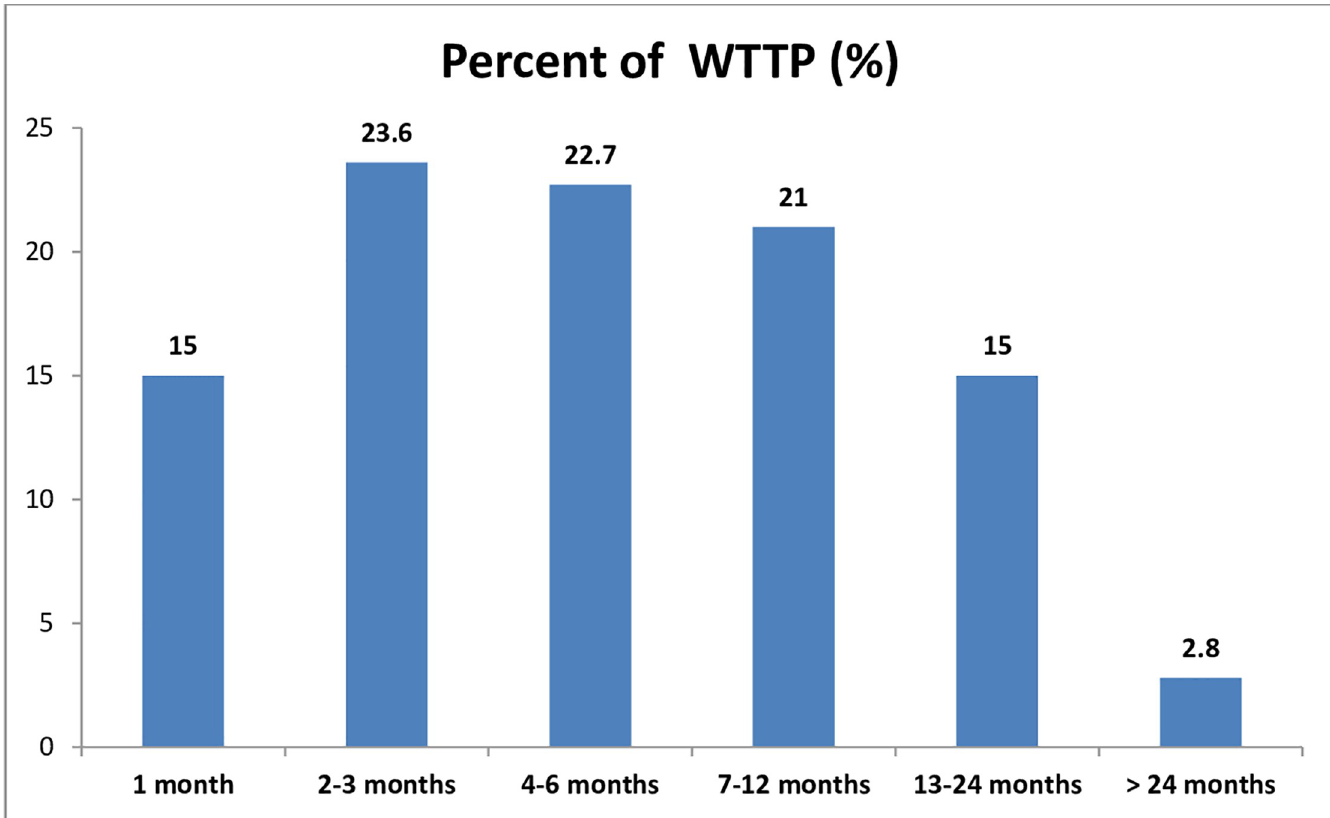
Fig 1. Waiting time to pregnancy of mothers with natural planned conception attended ANC service at AMHFs, 2020.